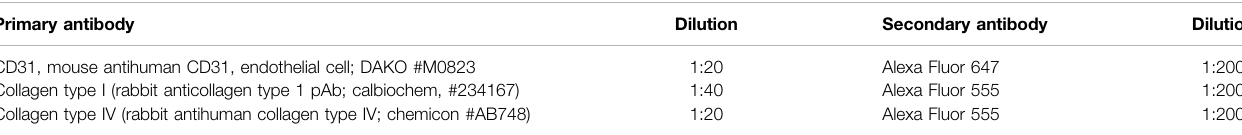
TABLE 1 | Antibody grid. Primary antibody Dilution Secondary antibody Dilution CD31, mouse antihuman CD31, endothelial cell; DAKO